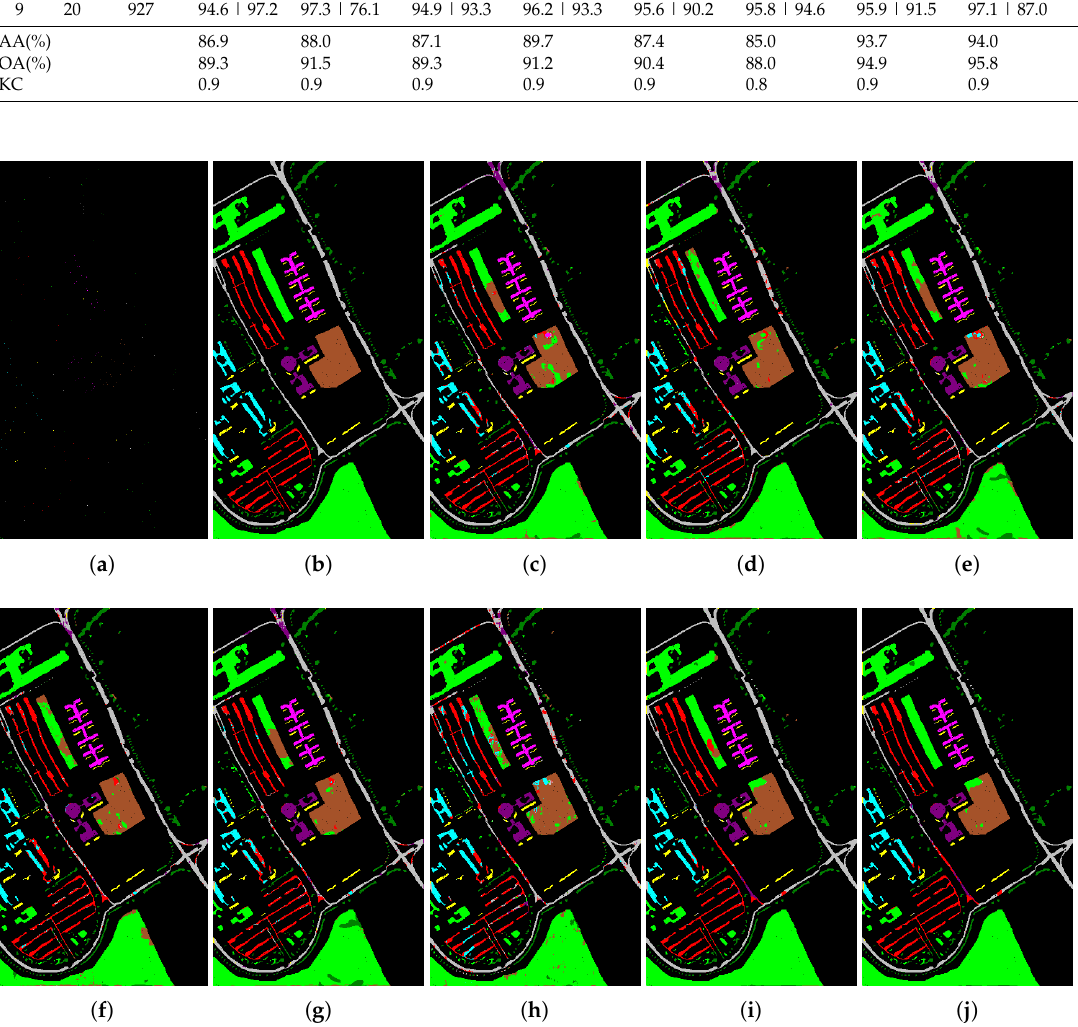
Figure 6. Classification maps of different DR models based on SVM on the Pavia University data with the Ground Truths (GTs) corresponding to the training and testing data. ( a ) Training GT. ( b ) Testing GT. ( c ) SVM. ( d ) SPPCA. ( e ) NWFE. ( f ) SLGDA. ( g ) LapCGDA. ( h ) LGSFA. ( i ) SaCGDA. ( j )